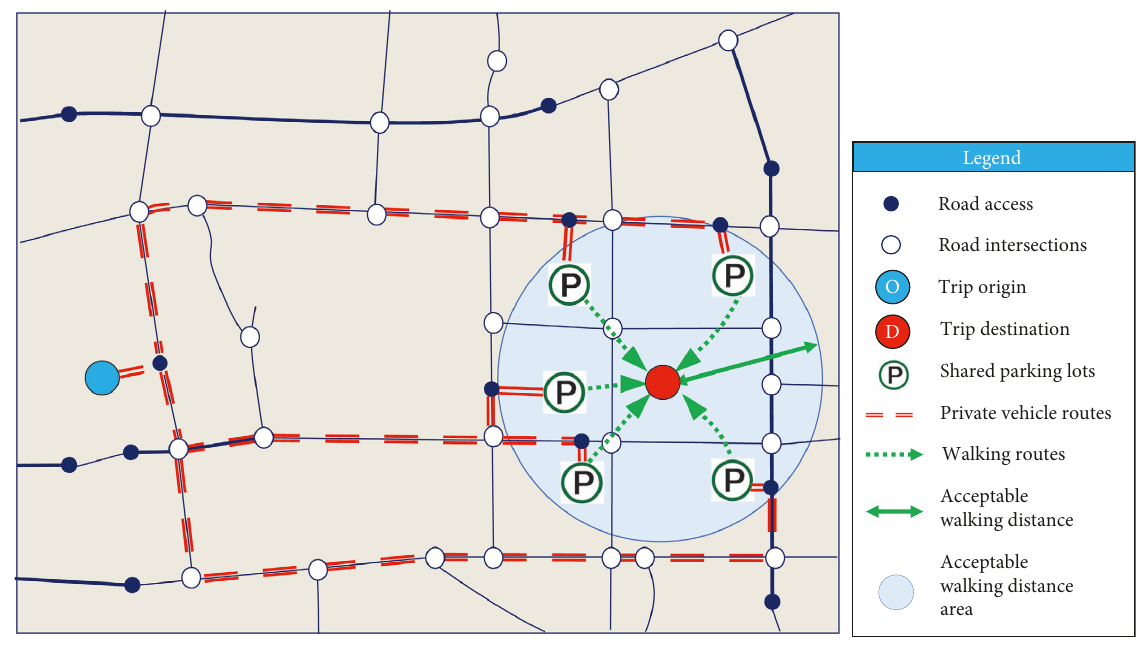
Figure 1: Schematic diagram of shared parking space reservation and recommended parking routes.